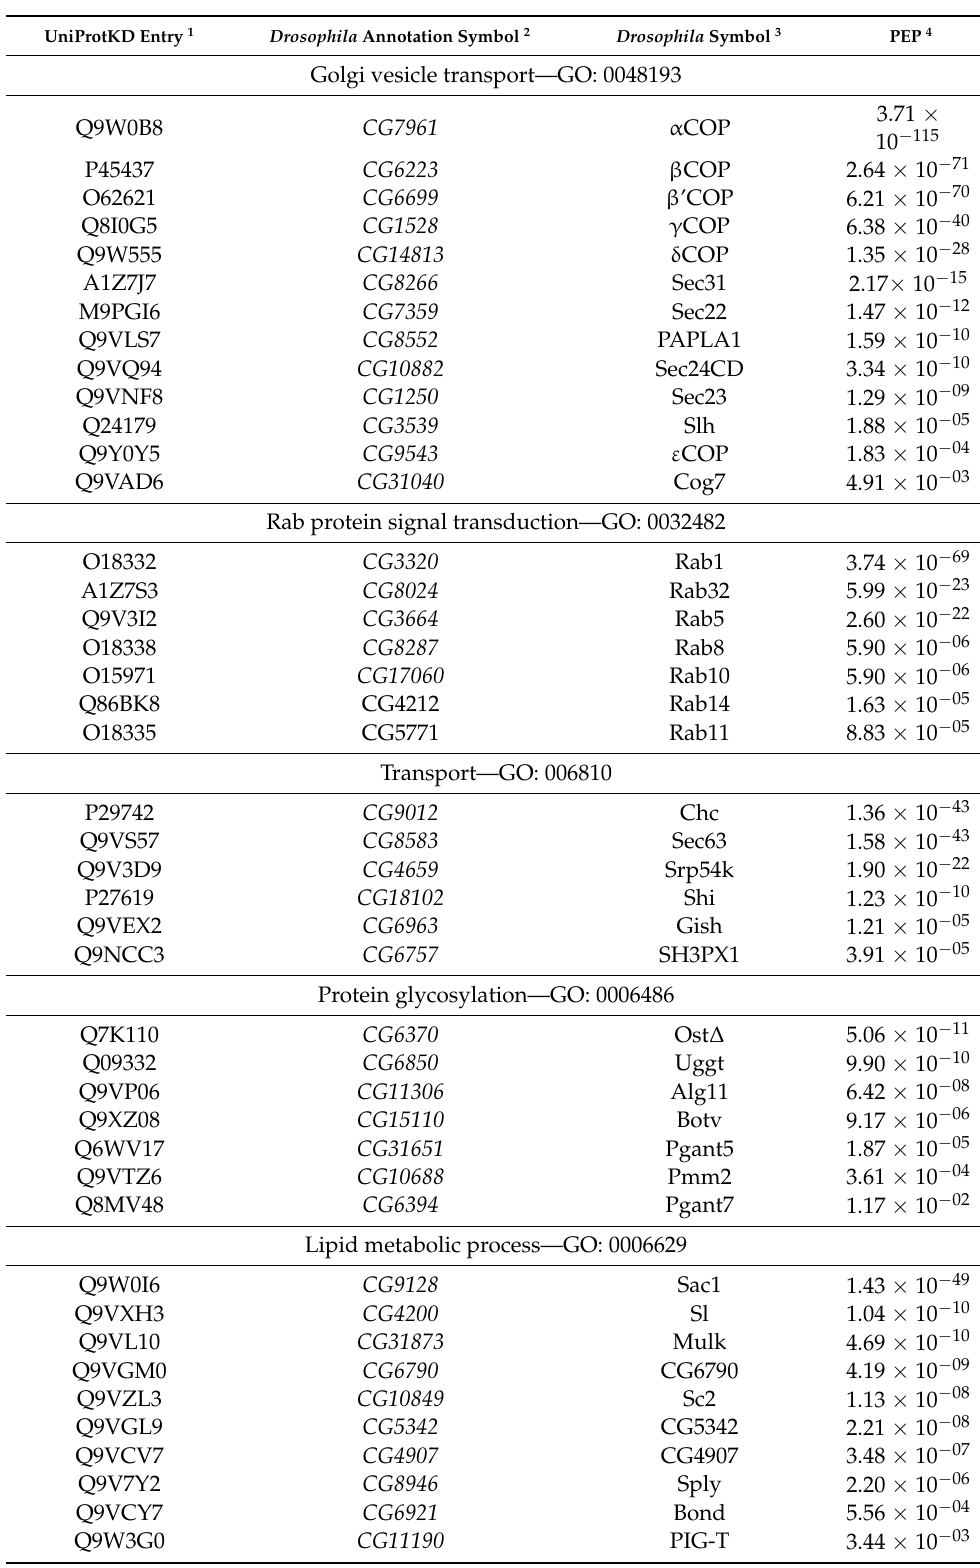
Table 1. Selected proteins interacting with dGOLPH3, categorized by function. The full list of hits in the dGOLPH3 interactome is shown in supplementary Table S1. Protein identifications were verified by manual inspection of MS/MS